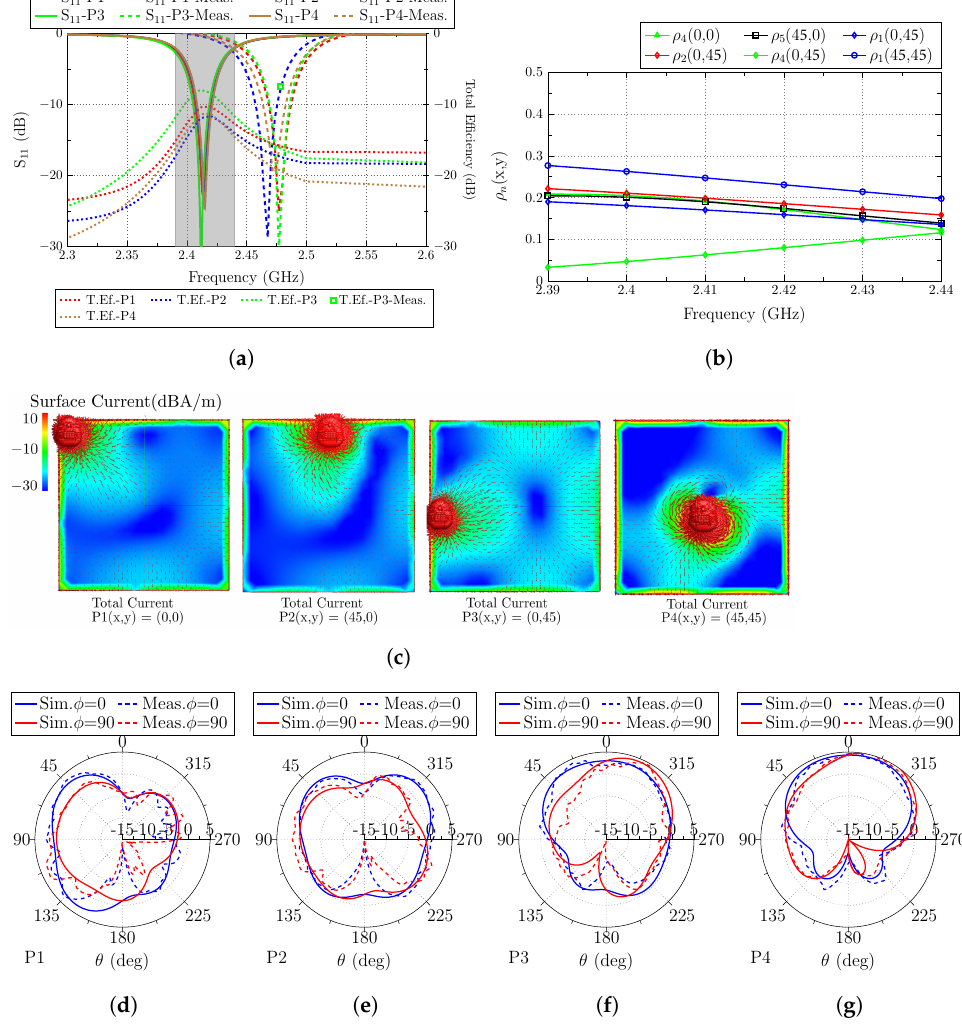
Figure 5. ( a ) Reflection coefficient (S 11 ) and total efficiency (dB) of the antenna located at the four analyzed positions (the frequency band colored in gray corresponds to the operating band analyzed with the correlation), ( b ) correlation (detailed in Equation (3)) of total and modal fields, ( c ) total current distribution of the antenna at the four positions, and radiation patterns at resonance when the antenna is placed at ( d ) P1(x,y) = (0,0), ( e ) P2(x,y) = (45,0), ( f ) P3(x,y) = (0,45), and ( g ) P4(x,y) =